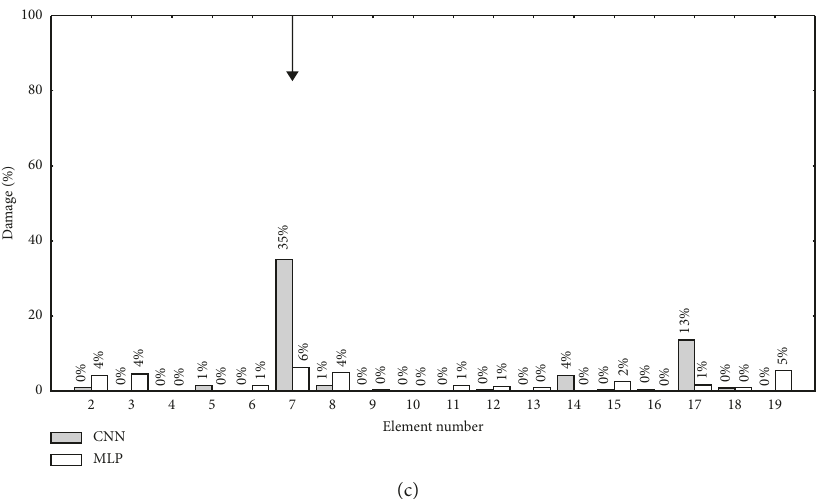
Figure 21: Results for damage scenario 1 according to (a) CNN and MLP models 1, (b) CNN and MLP models 2, and (c) CNN and MLP models